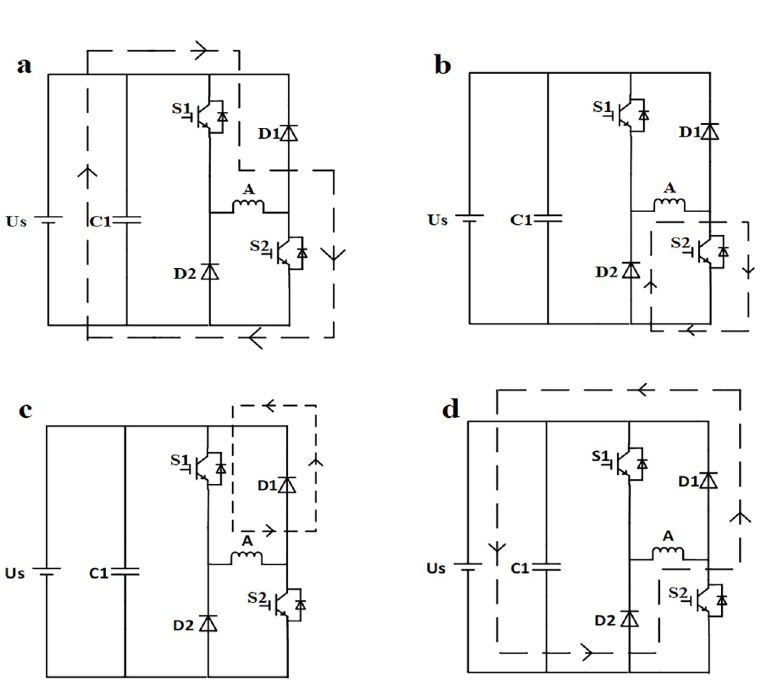
Fig 2. Working state of phase A. (a) Excitation ST1. (b) Lower freewheeling ST2. (c) Upper freewheeling ST3. (d) Demagnetization